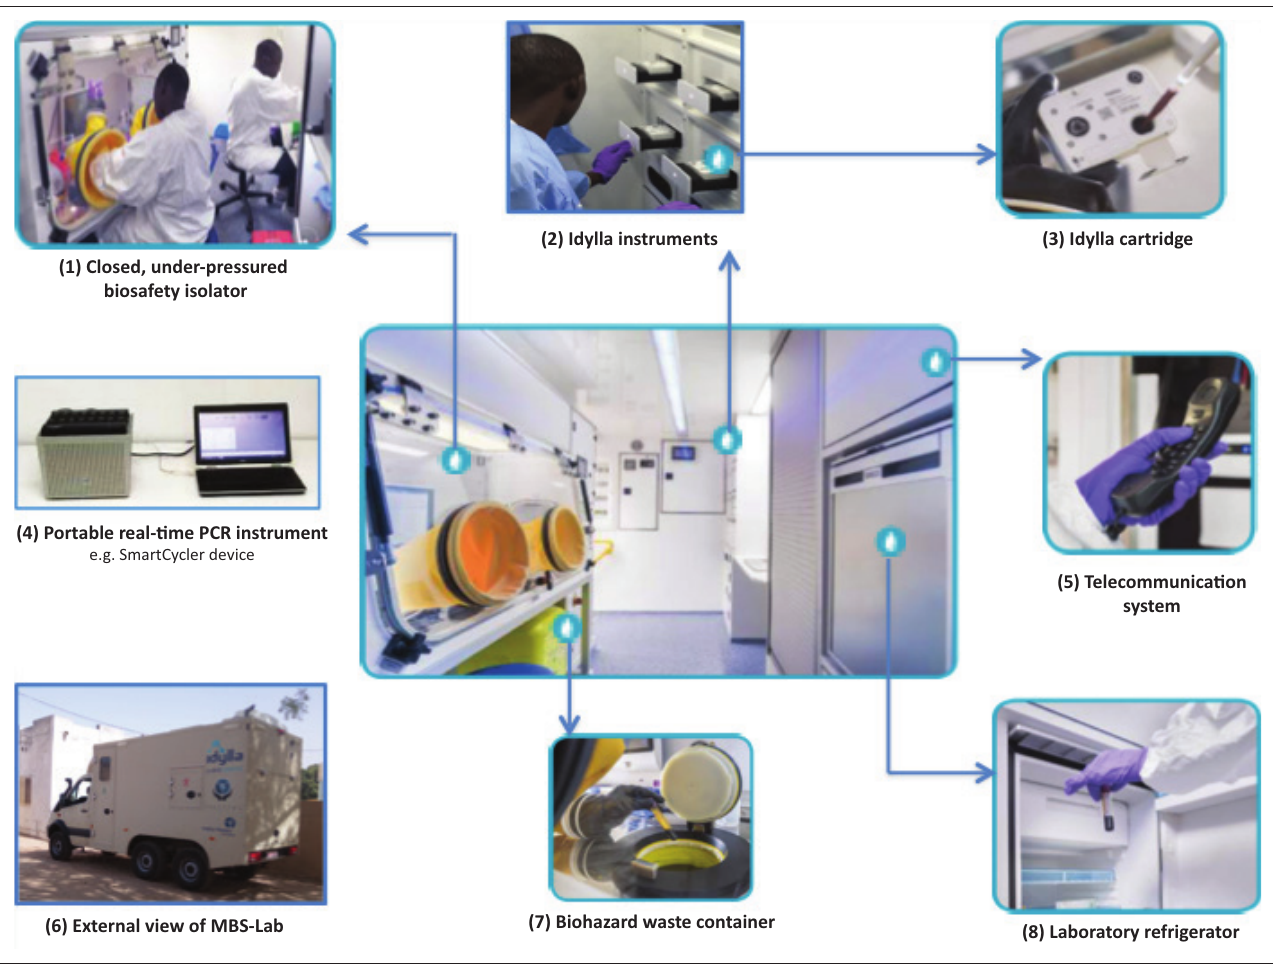
FIGURE 2: Features of the mobile biosafety laboratory and platforms, Senegal, 2017–2018. (1) Closed under-pressured biosafety isolator; (2) Idylla platform; (3) Idylla cartridge; (4) SmartCycler instrument; (5) Telecommunication system; (6) External view of the MBS-Lab; (7) Biohazard waste container; (8) Laboratory